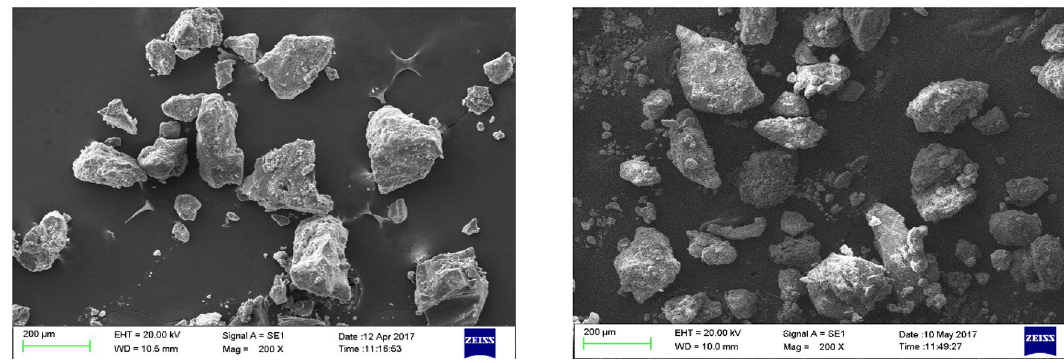
Fig. 4 Morphology of the blockage samples obtained from SEM of YB27-3H and YB102-1H (200×) Table 2 Results of element analysis of the blockage samples